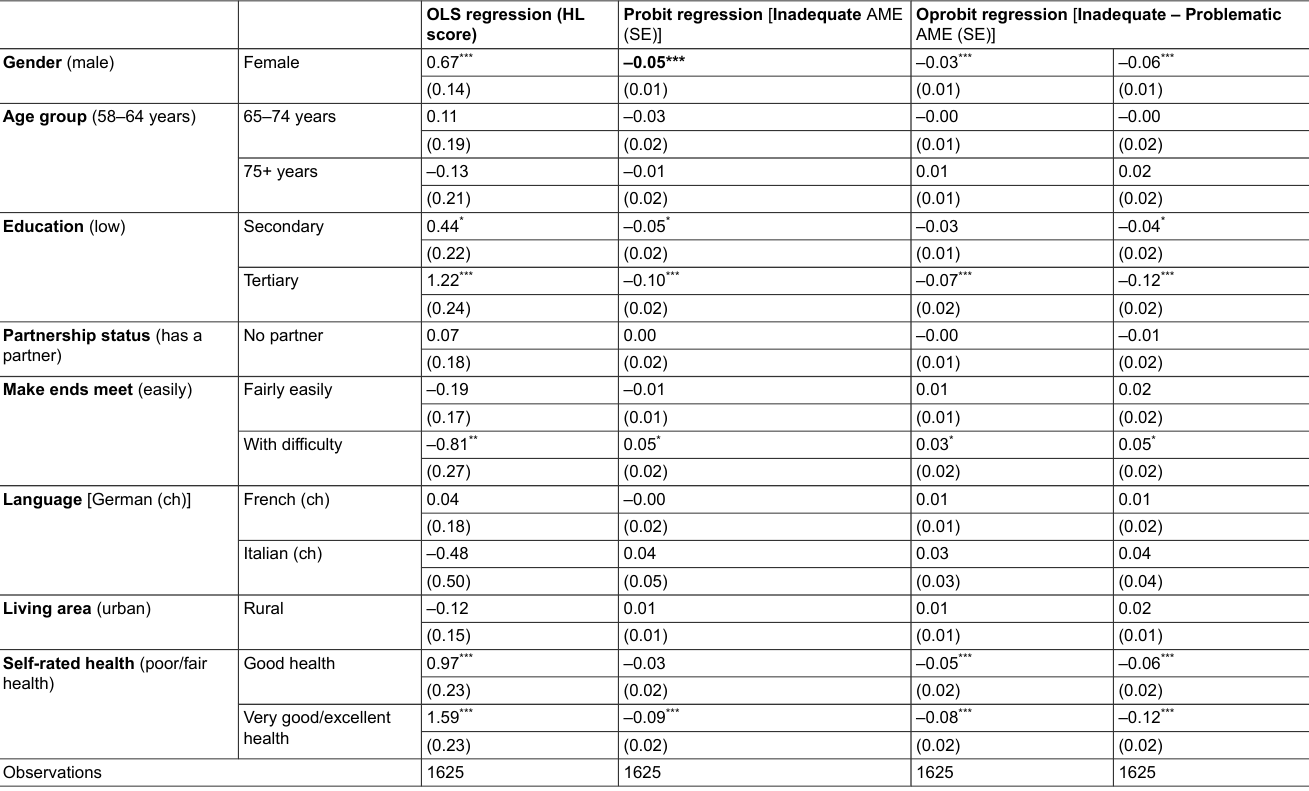
OLS regression (HL